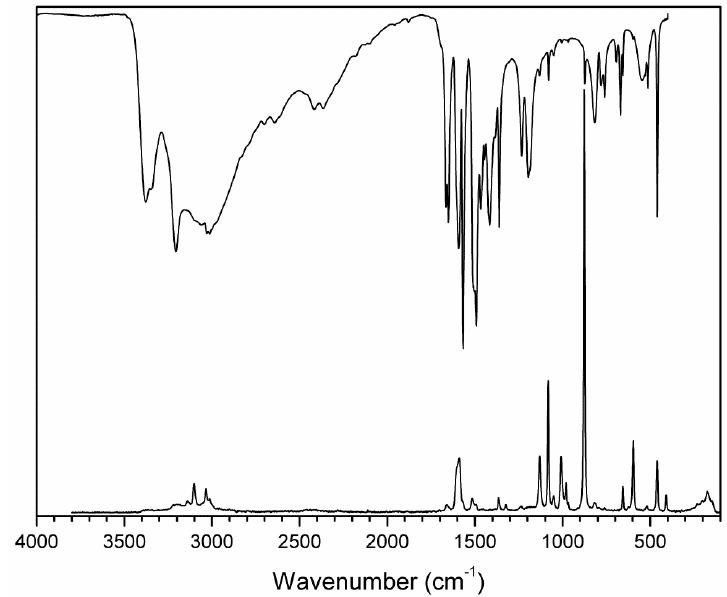
Figure 7. FTIR (compiled from nujol and fluorolube mulls) and FT Raman spectra of (2-AMP) 3 (H 3 BO 3 ) 2 .